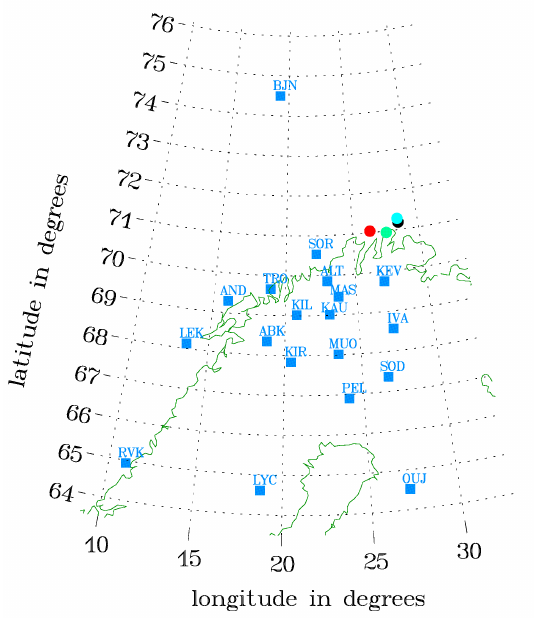
Fig. 2. Mapped positions of Cluster spacecraft to the ionosphere (dots, colours as in Fig. 1), and IMAGE magnetometer stations (squares with station